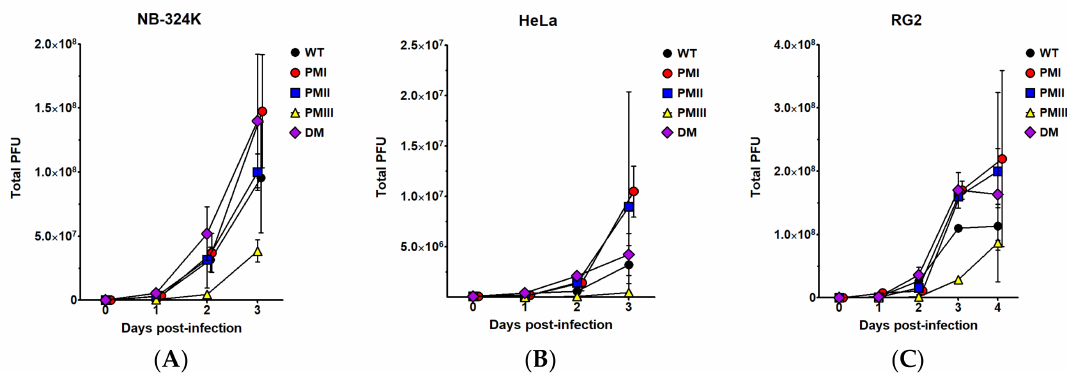
Figure 2. Enhanced infectious progeny production of H1-PM-I, H1-PM-II, and H1-DM in human but not in rat cell lines. Infectious particles of wt H-1PV and derived mutants were measured after infection (MOI, 0.5 PFU/cell) of ( A ) human NB-324k; ( B ) HeLa; and ( C ) rat RG-2 cell lines. The production of infectious particles (total PFU) was determined by plaque assays at the indicated times post-infection (p.i.) for the three cell lines. Results are given as the mean ± SD of plaque numbers measured in duplicate from ≥ 3 independent